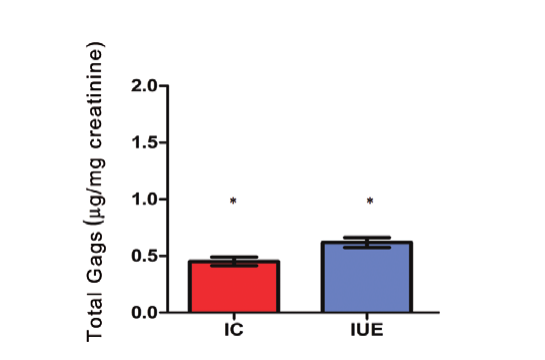
Figure 1 - Urothelium concentration of sulfated GAG of IC/ BS and control (SUI) patients. Vertical bars represent the standard deviations. Statistically significant deviation was not found between groups (p = 0.62).